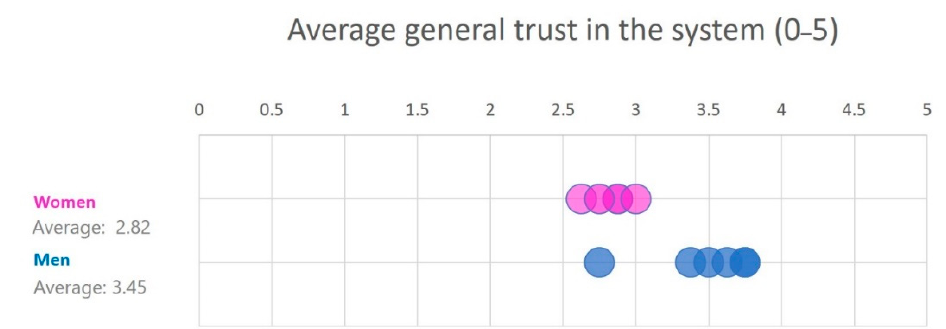
Figure 14. Correlation between gender and trust.